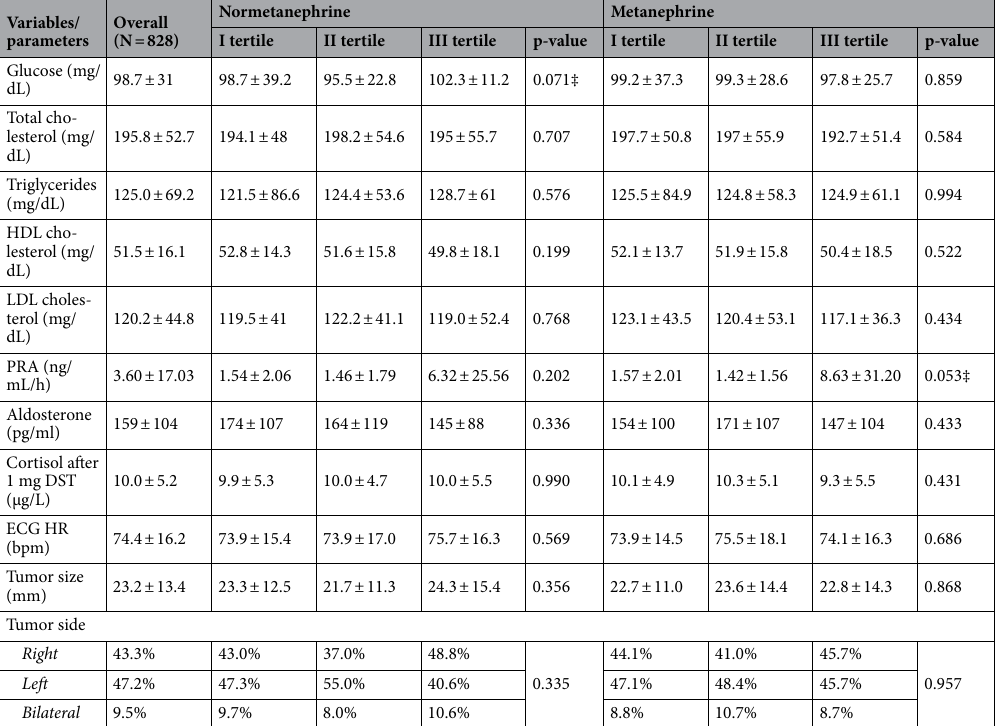
Table 2. Biochemical, hormone and tumor-specific variables/parameters according to tertiles of normetanephrine and metanephrine levels. DST, dexamethasone suppression test; eGFR, estimated glomerular filtration rate; HDL, high density lipoprotein; LDLc, low density lipoprotein calculated; PRA, plasma renin activity. The table shows p-values of the statistics analyzing differences between the three tertiles. ‡ Significant difference between II tertile and III